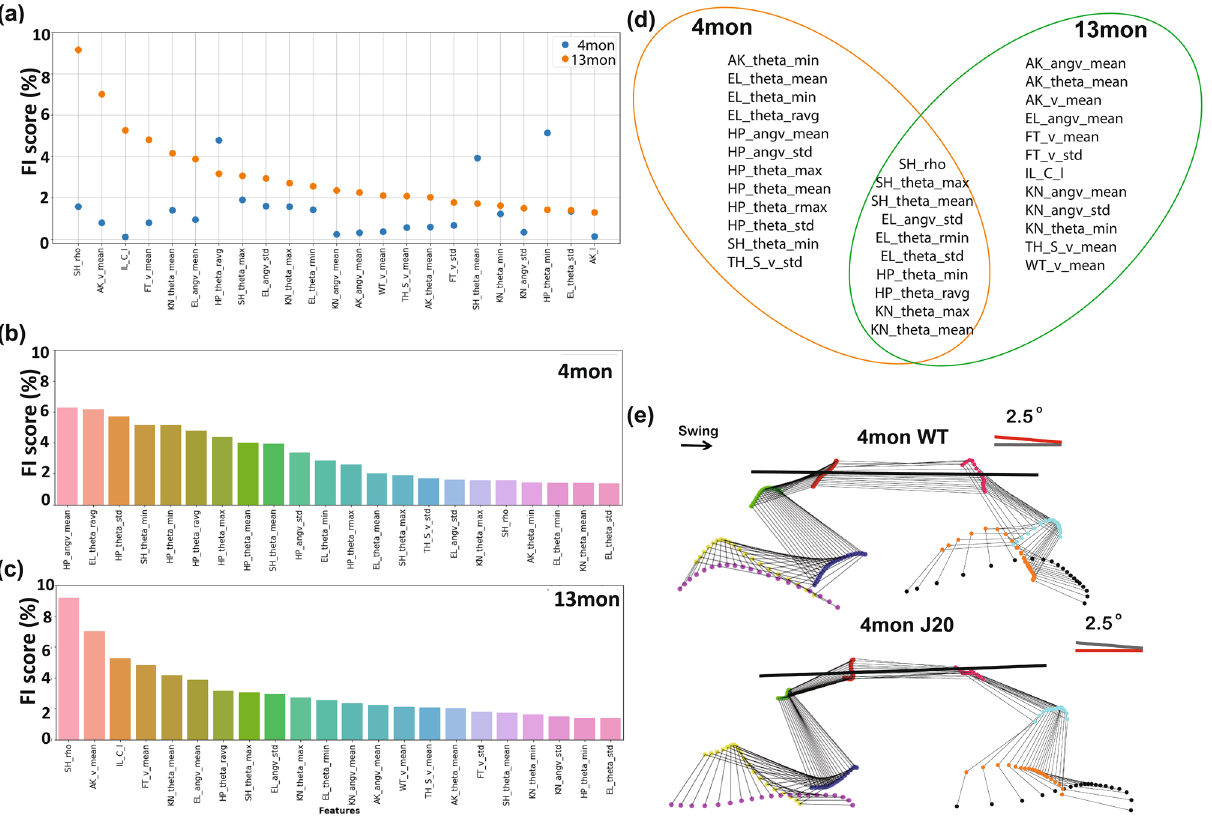
Figure 2. Feature importance (FI) scores (%) revealed age-specific kinematic deficits in 4mon and 13mon J20 mice. ( a ) A summary of FI scores (%) from the 4-month-bilateral (4mon-BL), and 13-month-bilateral (13mon-BL) datasets; ( b ) ranking of 4mon-BL FI scores (%); and ( c ) ranking of 13mon-BL FI scores (%). ( d ) A diagram of the 22 highest-ranked features of the 4mon, 13mon, and full bilateral datasets circled in orange, green, and blue, respectively. ( e ) A 2.5-degree tilt of the trunk was observed in the 4mon J20 when compared to their littermates in the WT group. Thus, subtle differences between genotypes could be detected even from data acquired at 4 months of age. Panels generated through Python 3.7, MATLAB 9.2, and Adobe Illustrator